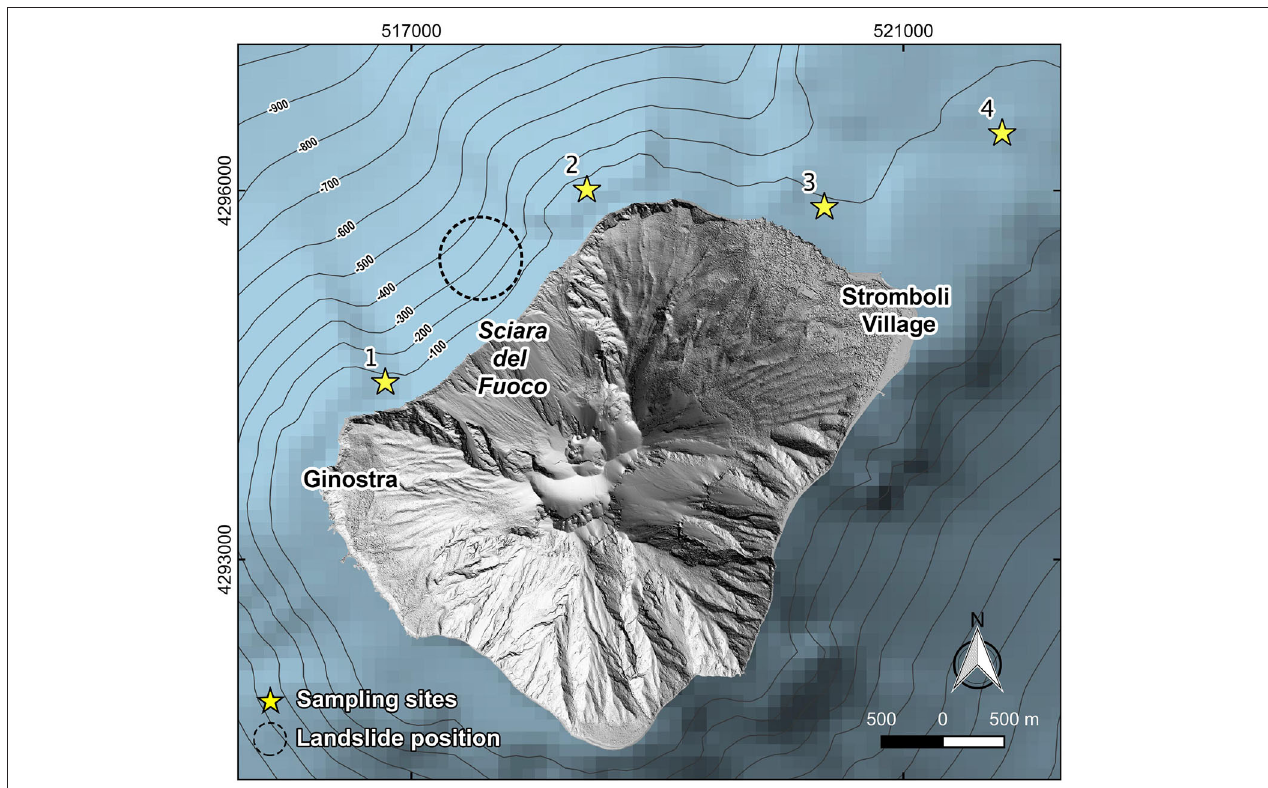
FIGURE 2 | Topography and bathymetry of the island of Stromboli. Stars indicate the positions of the actual (1 and 2) and virtual gauges (3 and 4), where simulated waves are sampled. The initial position of the 2002 submarine landslide identified by Fornaciai et al. (2019) is indicated by the